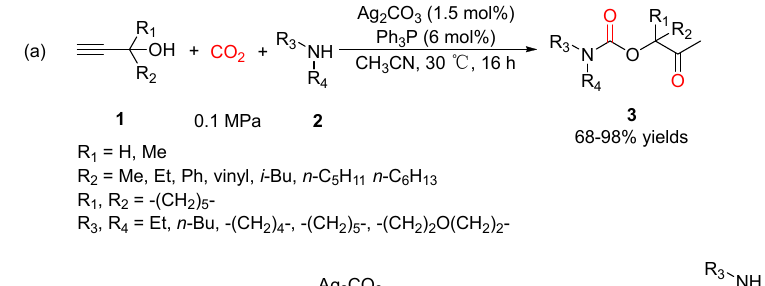
and secondary amines.